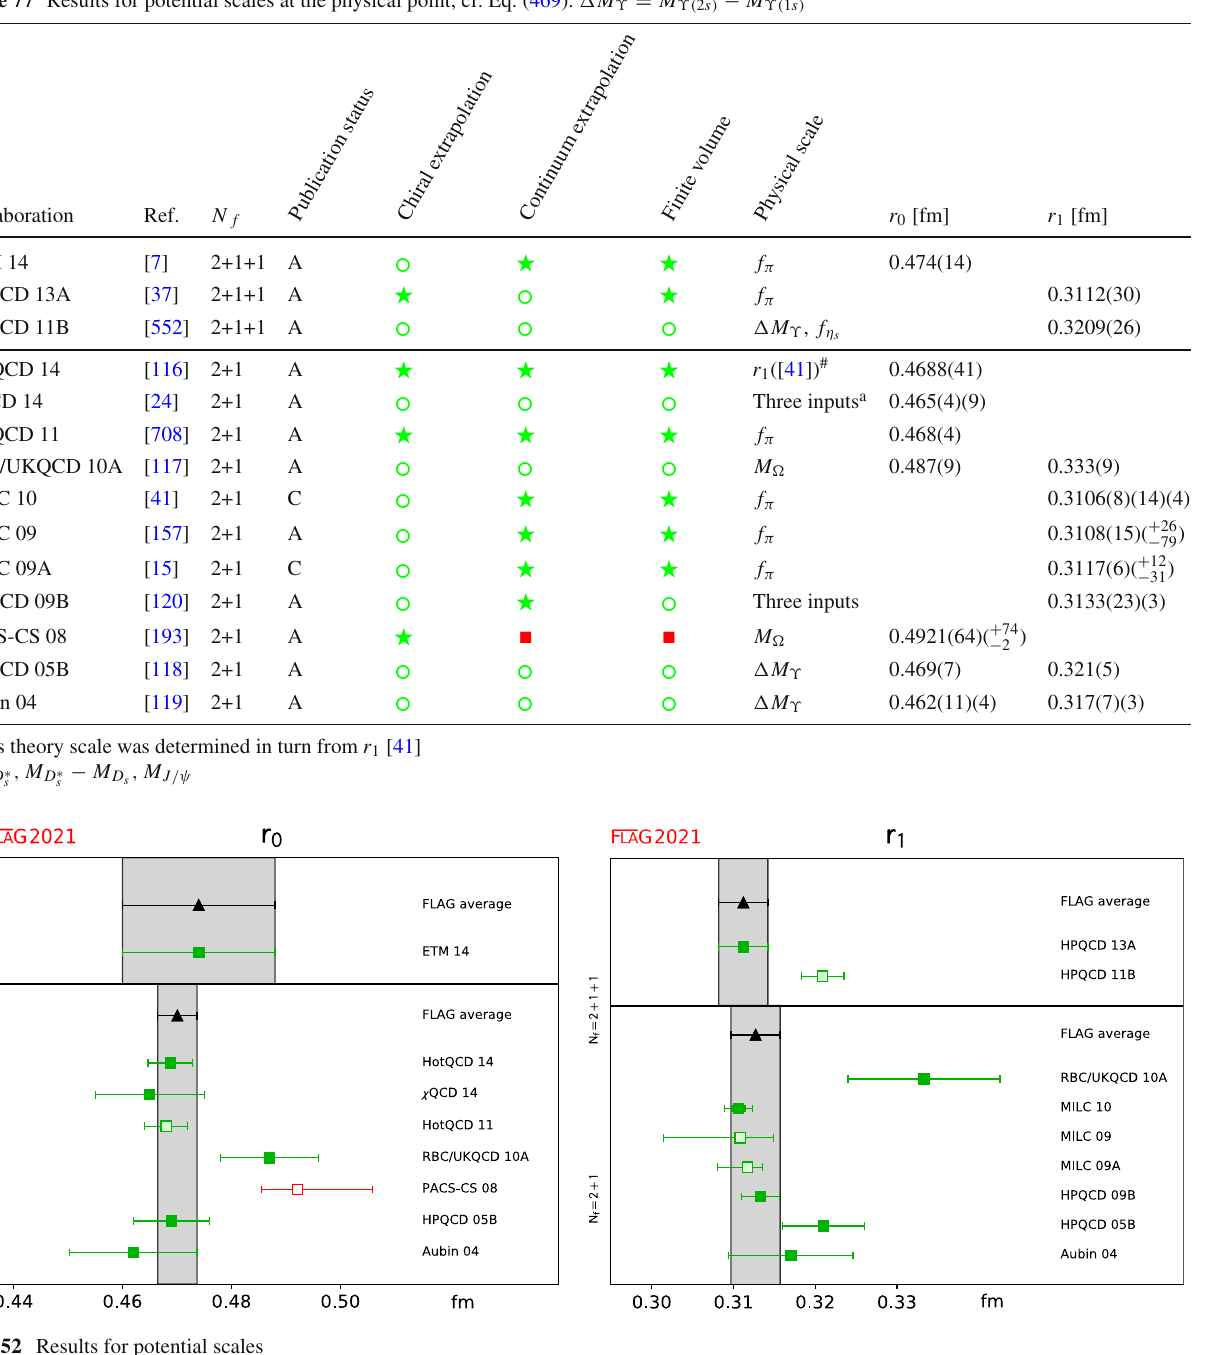
Table 77 Results for potential scales at the physical point, cf. Eq. (469). (cid:16) M ϒ = M ϒ( 2 s ) − M ϒ( 1 s )